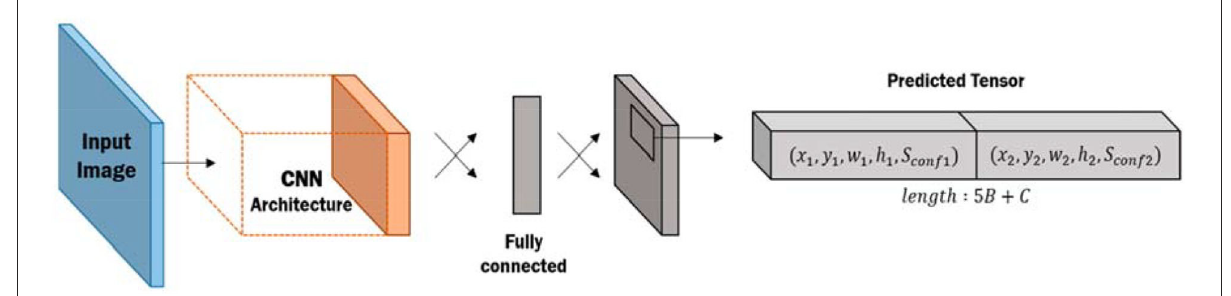
FIGURE1 YOLO network architecture diagram.